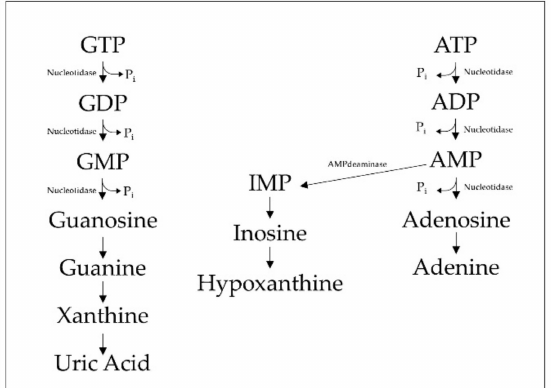
Figure 1. Purine metabolism. The guanine nucleotides guanosine-5 (cid:48) -triphosphate (GTP), guanosine-5 (cid:48) -diphosphate (GDP) and guanosine-5 (cid:48) -monophosphate (GMP) are sequentially dephosphorylated by ecto-nucleotidases thus generating guanosine. Further enzymatic reactions convert Guanosine into guanine, which is then converted into xanthine and subsequently to uric